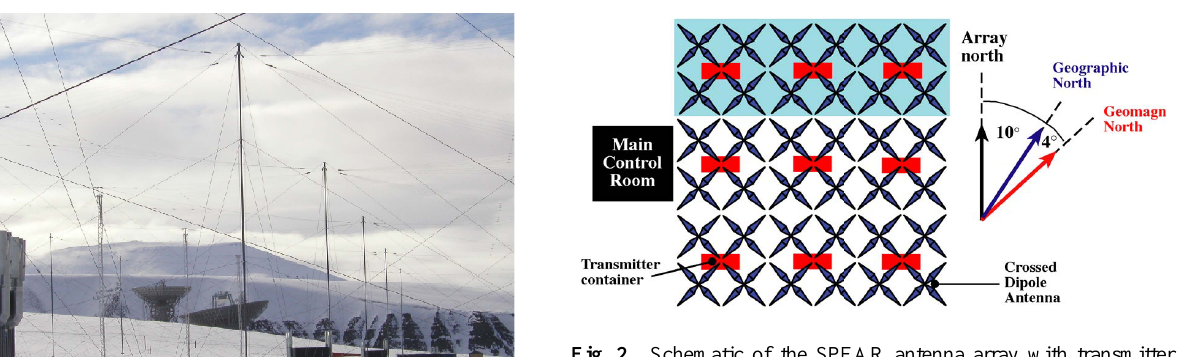
Fig. 2. Schematic of the SPEAR antenna array with transmitter containers and dipoles. The (blue) shaded area shows the planned extension. The orientation of the array is indicated by the